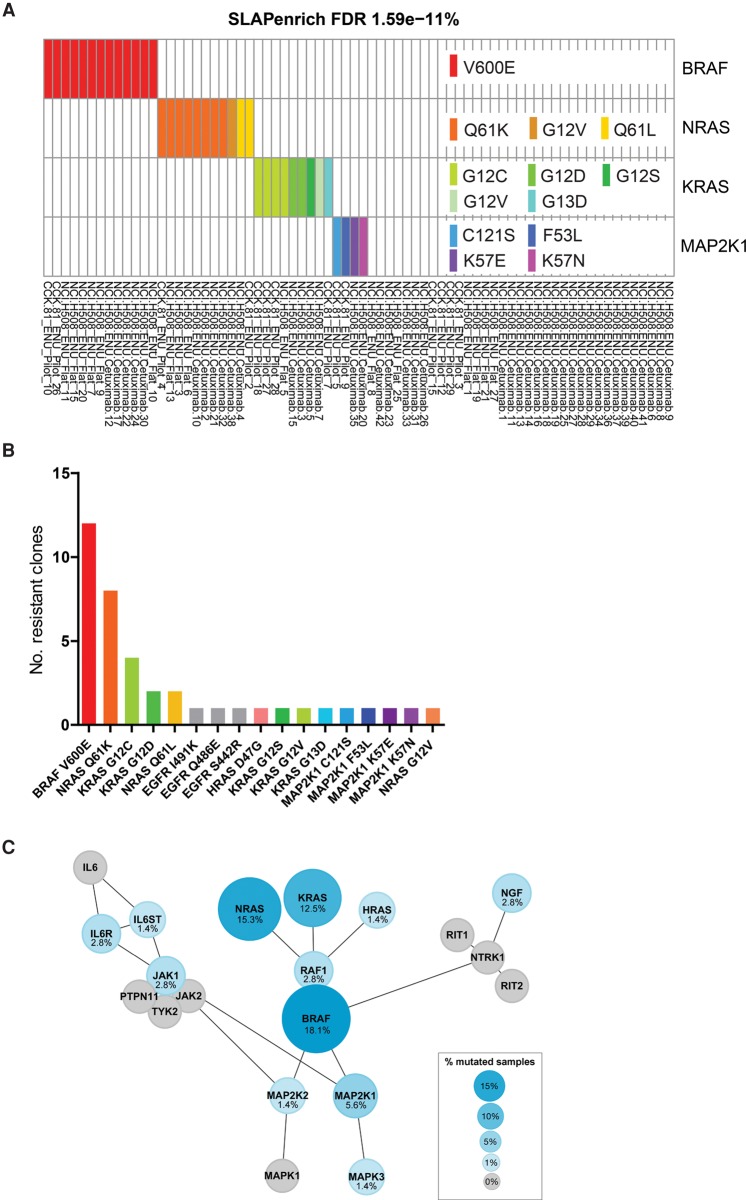
ENU mutagenesis identifies clinically relevant mutations and pathways. (A) The pathway most significantly enriched with mutations, “Signaling to P38 via RIT and RIN,” contains many of the key genes of the canonical MAP kinase pathway, and those are mutated in a mutually exclusive manner. Here, we show those genes mutated in at least three individual clones. Whole-exome sequence from 72 Cetuximab resistant ENU clones was used to identify pathways using the SLAPenrich algorithm. Amino acid substitutions are labeled for the subset of genes most frequently mutated in the pathway and/or demonstrating mutual exclusivity with other mutations. (B) Cetuximab resistance mutations. Frequency of likely ENU-derived drug resistance mutations across 42 resistant clones. The amino acid consequence of each mutation is indicated with the gene name. (C) A visual representation of the all mutated genes that comprise the “Signaling to P38 via RIT and RIN” pathway, indicating gene–gene interactions and the hierarchy of signaling. Only those genes mutated in at least three clones were taken forward for validation.